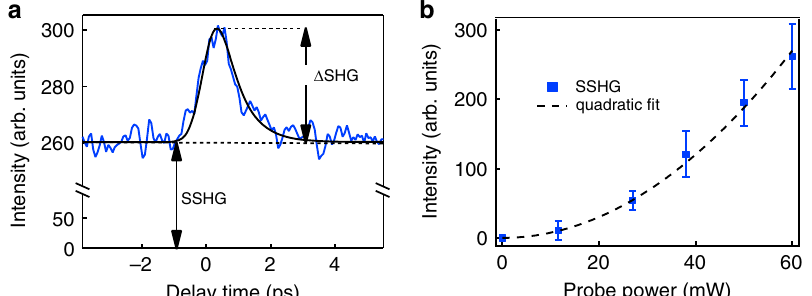
Fig. 2 Second harmonic probe signal from a pentacene thin fi lm. a SHG intensity as a function of pump-probe delay, with the probe polarization angle set at 60 ˚ with respect to vertical. Two distinct contributions to the signal may be noted — a constant background (labeled SSHG), and a pump-induced signal at zero delay (labelled Δ SHG). The solid black curve is the convolution of instrumental response and simulation of the MER response based on the torque model 12 . b The background SSHG signal varies quadratically with input probe power as expected (dashed-curve). The error bars were determined by the variance of the signal before time